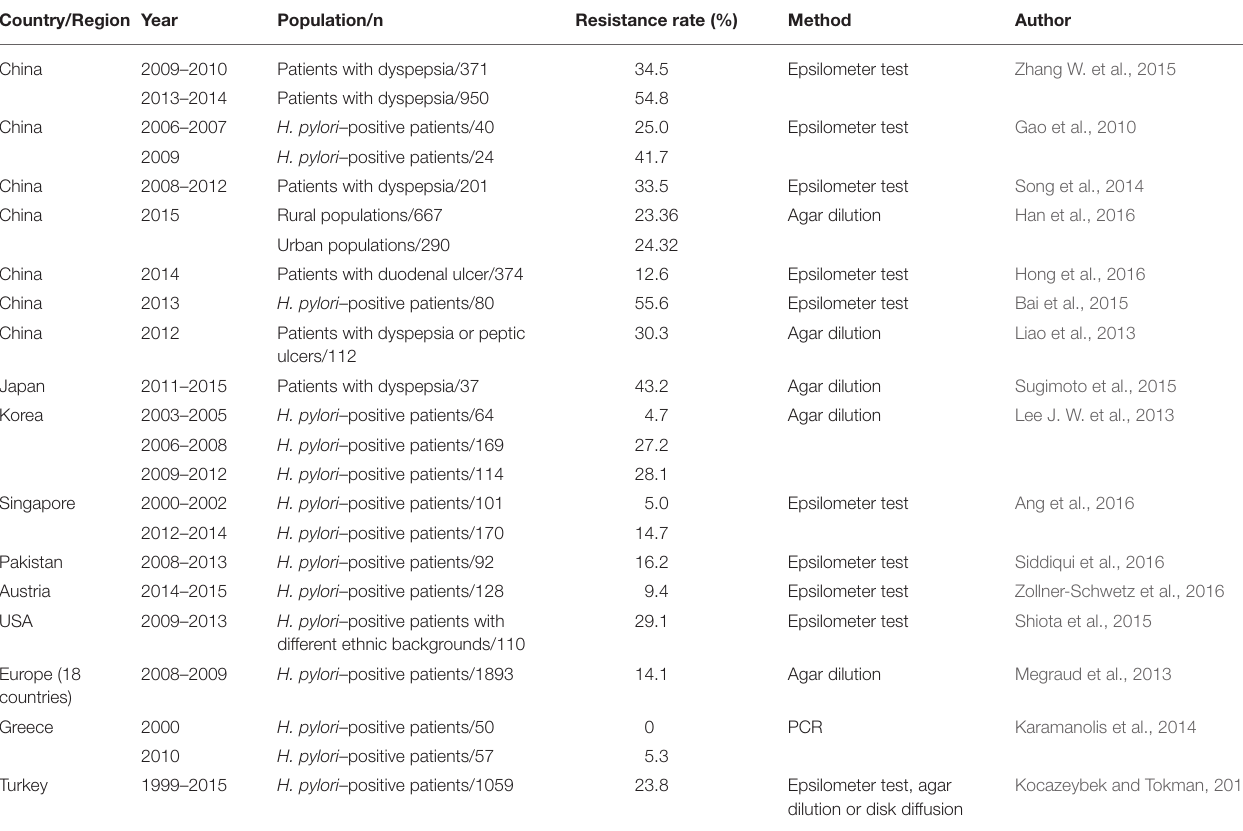
TABLE 4 | Primary H. pylori clarithromycin